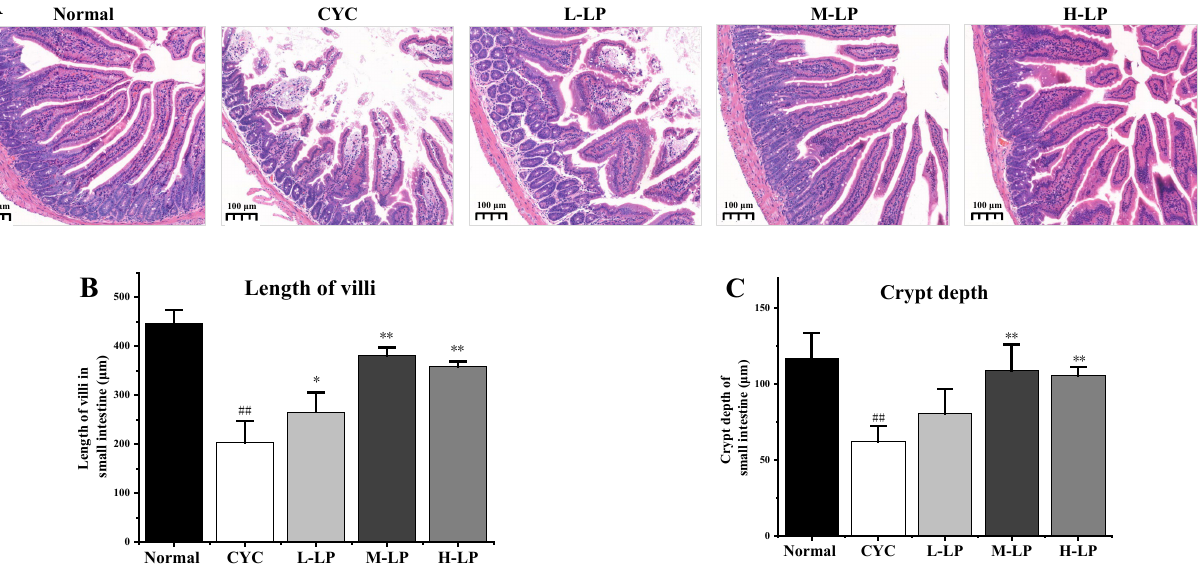
Figure 2. Effects of LP on histological morphology of small intestine in mice. ( A ) HE staining of small intestine (10 × ); ( B ) Length of villi in the small intestine; ( C ) Crypt depth of small intestine. Note: n = 3, ## p < 0.01 vs. Normal group, * p < 0.05, ** p < 0.01 vs. CYC group.